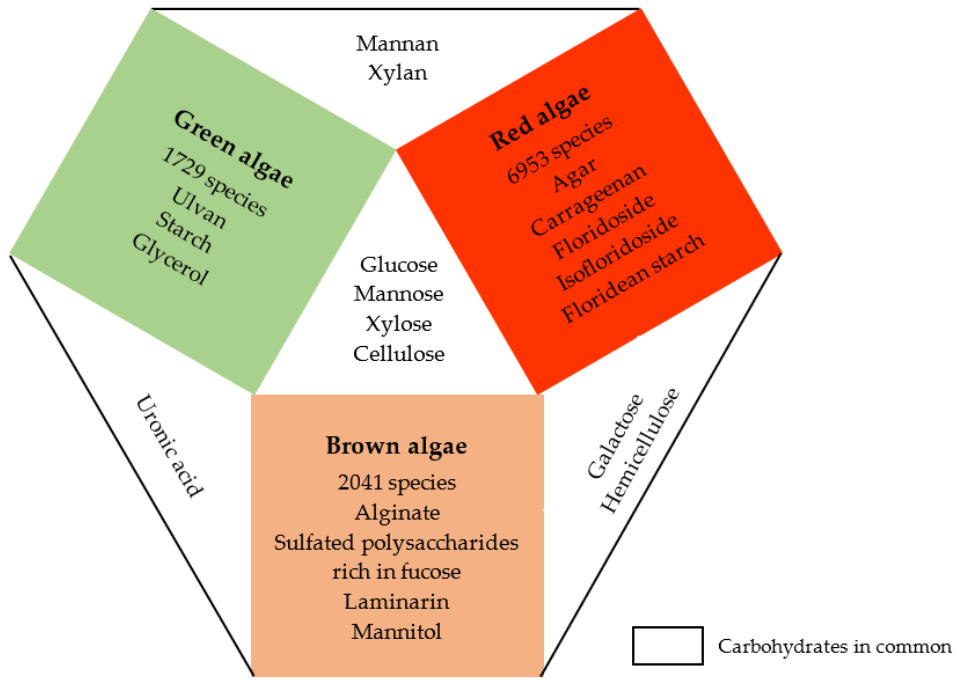
Figure 6. Cell wall polysaccharides and stored sugars present in three groups of seaweeds.